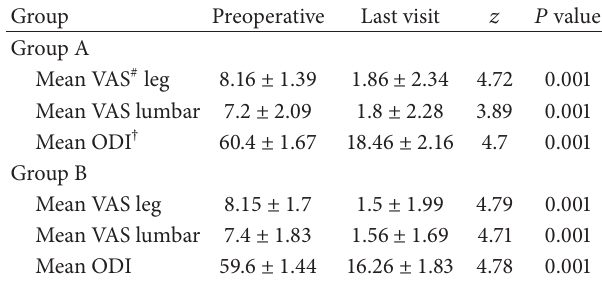
Table 2: Improvement in pain and disability.